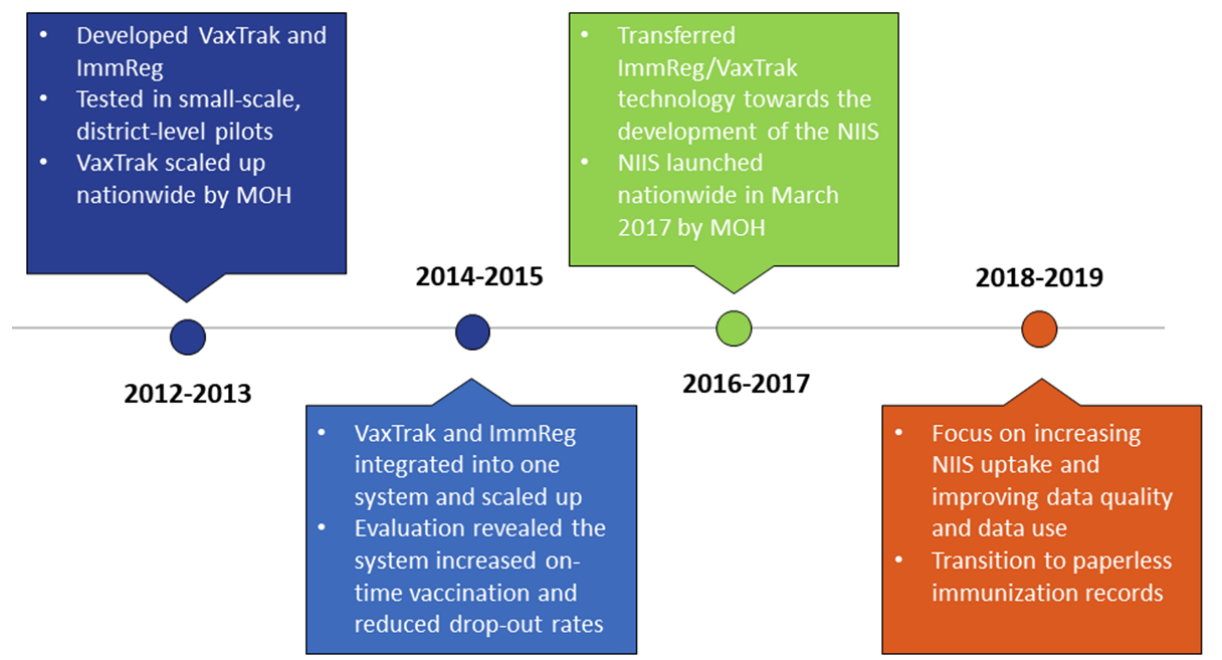
Figure 4. Timeline of the electronic immunization registry introduction and scale-up in Vietnam. MOH: Ministry of Health; NIIS: National Immunization Information